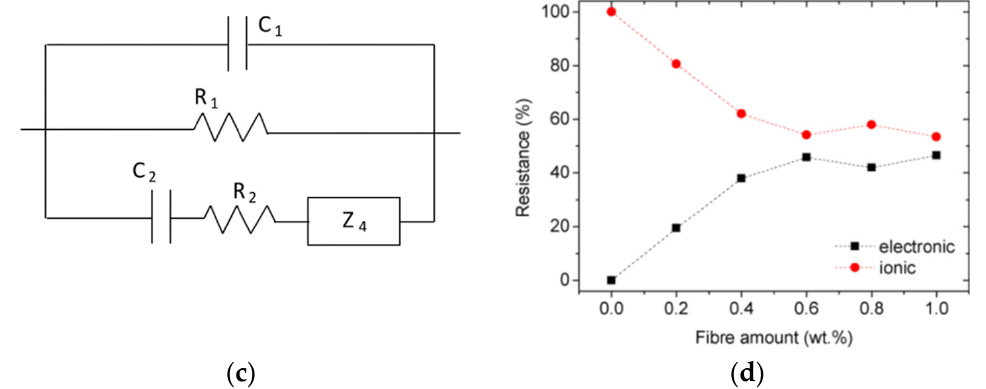
Figure 9. ( a ) Schematic representation of the dependence of the electrical conductivity on the conductive filler content. ( b ) High-frequency Nyquist impedance plots show the effect of the addition of carbon fibers. ( c ) Electrical equivalent circuit for fiber-reinforced samples at a concentration below the percolation limit. ( d ) Dependence of the ionic and electronic conductivities upon the fiber content. The figures are taken from [42,43].